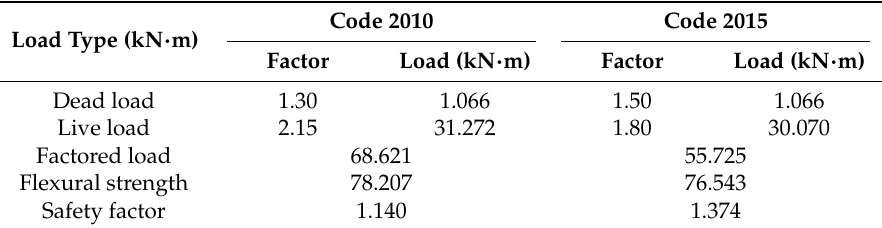
Table 4. Load combination and flexural strength.